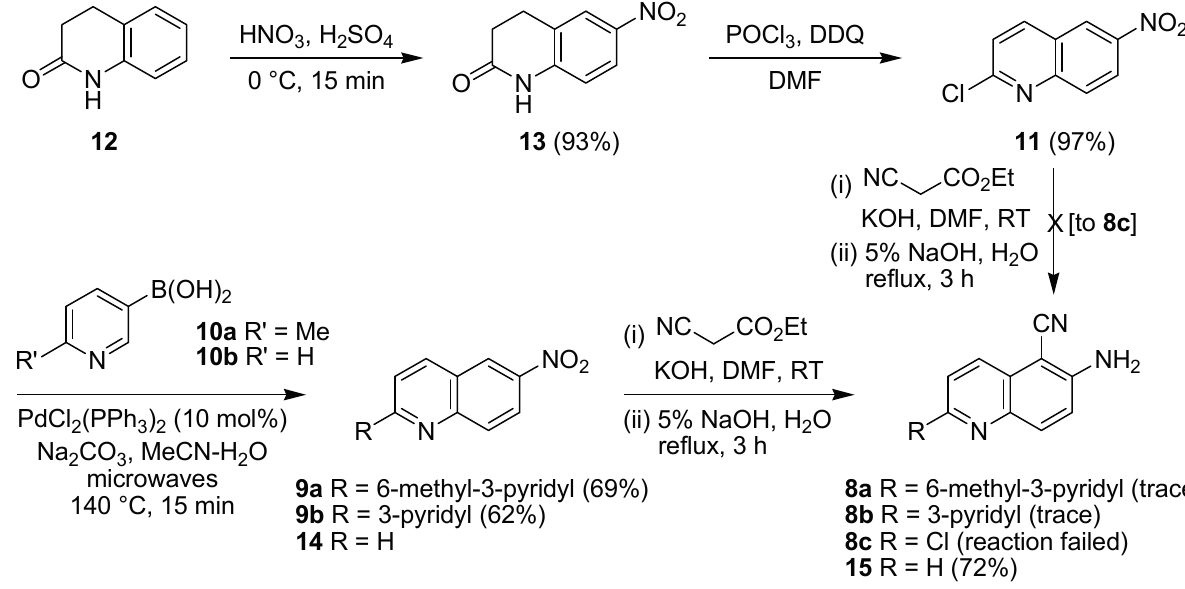
Figure 6. Synthesis of chloroquinoline 11 and subsequent Suzuki-Miyaura